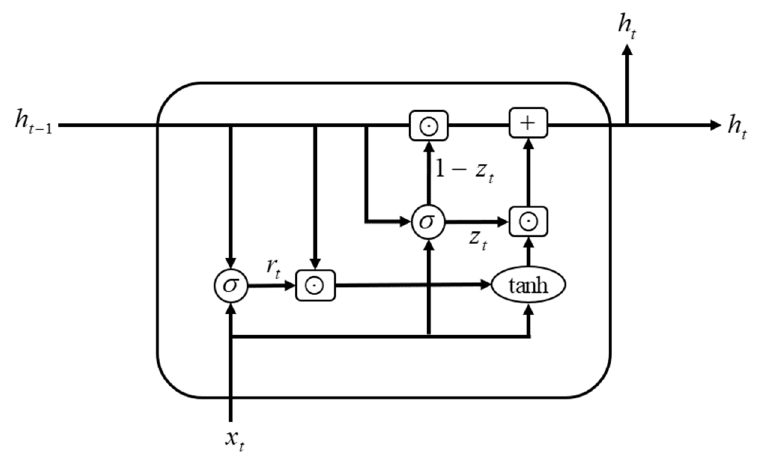
Figure 2. The architecture of the GRU.